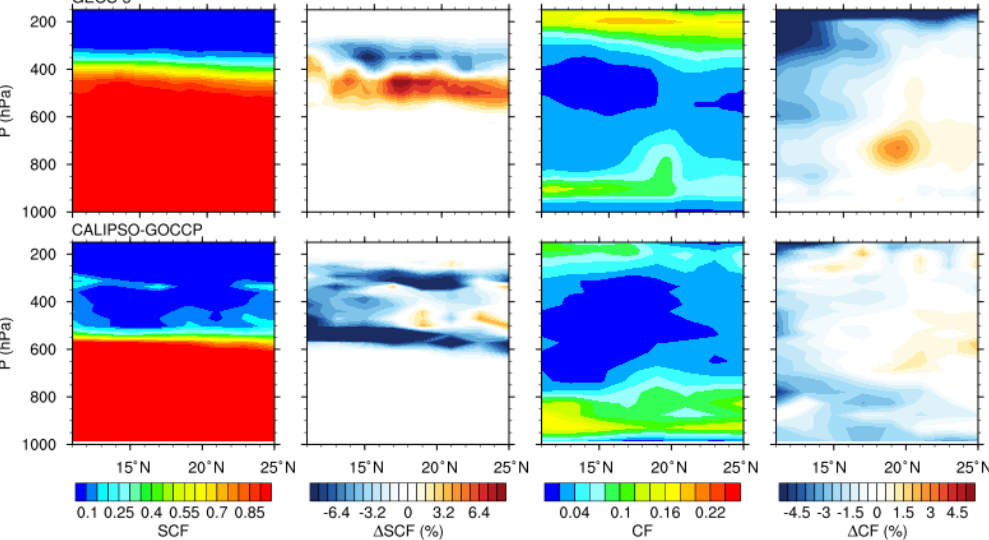
Figure 4. Zonal mean anomalies for JJA supercooled cloud fraction ( (cid:49) SCF) and cloud fraction ( (cid:49) CF) from the GEOS (top panels) sim- ulation and the CALIPSO-GOCCP (bottom panels) dataset. Also shown are the anomalies with respect to the 2007–2017 climatology (excluding 2008).